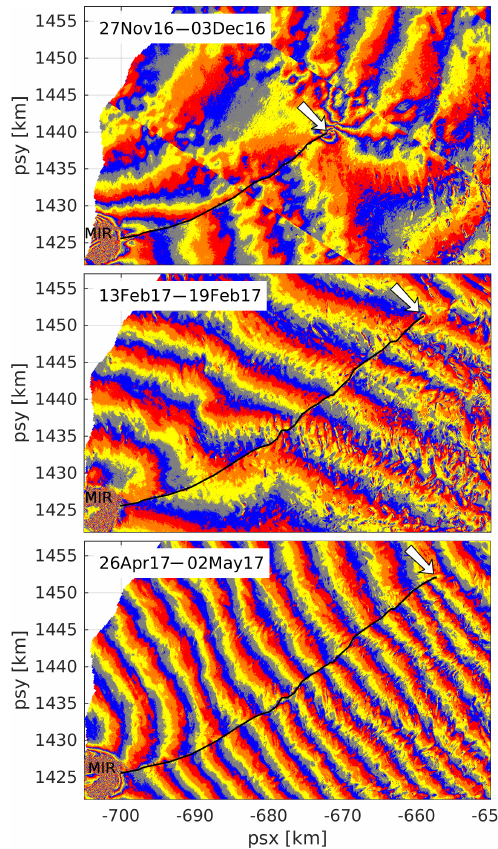
Figure 6. A selection of interferograms obtained about 2 months apart, showing the progress of Halloween Crack as it propagated from the McDonald Ice Rumples (MIR) towards the east. White arrows point towards the eastern tip of the